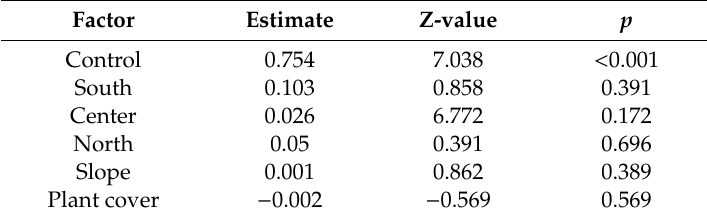
Table 2. Resultsofthegeneralizedlinearmixedmodels(GLMM)onbryophytesrichnessandenvironmental variables (zone, site, slope, and plant cover). The random variable site was non-significant. Factor Estimate